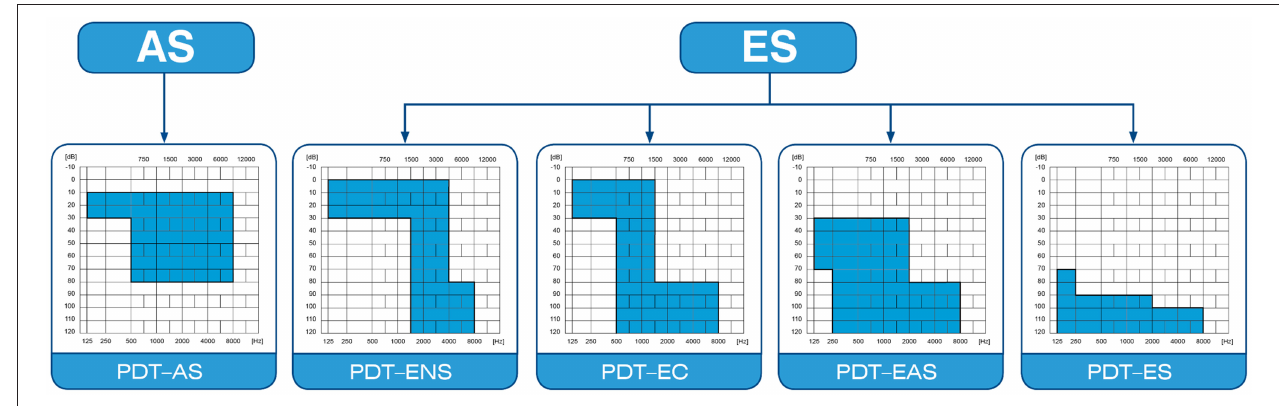
FIGURE 1 | Four categories of partial hearing loss (6, 29,